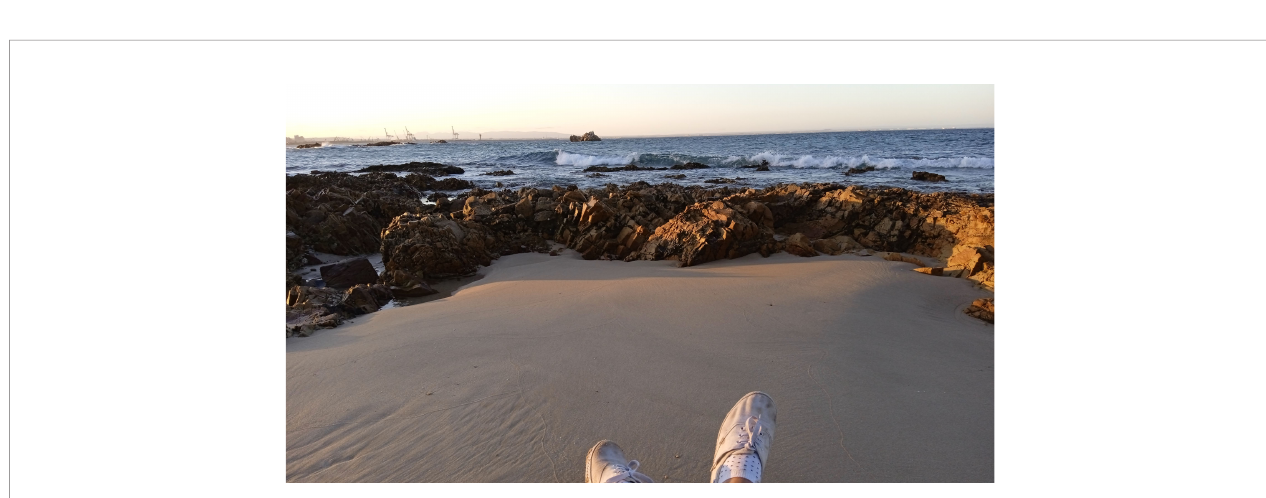
FIGURE 9 | Photograph by Tarryn Swartbooi at Summerstrand, Gqeberha, emphasising the sense of calm she feels when she is near the